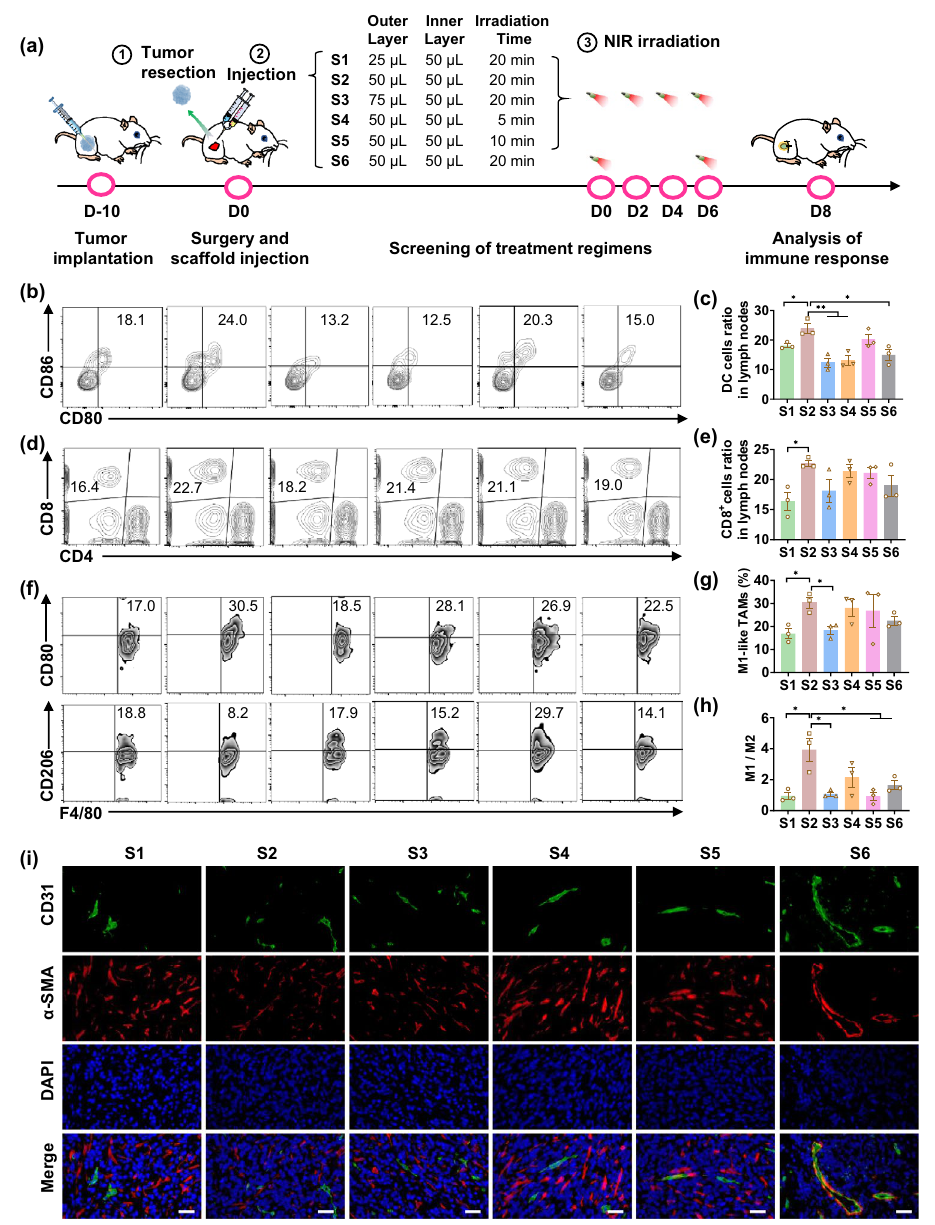
Fig. 3 Postsurgical immune responses of different DLG-based treatment strategies on 4T1-tumor-bearing mice. a Schematic depiction of the screening process of different treatment strategies. DLG outer layer: SG@LG35/65; DLG inner layer: aCD47@LG50/50; Dose of sorafenib: 50 μg per mouse; Dose of aCD47: 70 μg per mouse. b , c The representative flow cytometry analysis ( b ) and relative quantification ( c ) of DCs in lymph nodes of tumor resected mice (Gated on CD11 + CD80 + CD86 + cells). Data are shown as means ± SEM ( n = 3). d , e Representative flow cytometry analysis ( d ) and relative quantification ( e ) of tumor-infiltrating T cells in lymph nodes (gated on CD8 + cells). Data are shown as means ± SEM ( n = 3). f Representative flow cytometry analysis of M1-like macrophages (CD80 + ) and M2-like macrophages (CD206 + ) gating on F4/80 + CD11b + cells. g Relative quantification of M1 macrophages (CD80 + ) gating on F4/80 + CD11b + cells. Data are shown as mean ± SEM ( n = 3). h The ratio of M1/M2 in different groups. Data are shown as mean ± SEM ( n = 3). i Immunofluorescence staining of tumor microves- sels in tumor tissue on Day 8 after different treatments. The vascular endothelial cells were stained with the FITC-anti-CD31 antibody (green); the vascular smooth muscle cells were stained with Cy5-anti-α-SMA antibody (red); the cell nucleus was stained with DAPI (blue) (Scale bar: 100 μm). The statistical comparison between groups was performed following the student’s t test (two-tailed). * p < 0.05 and ** p <